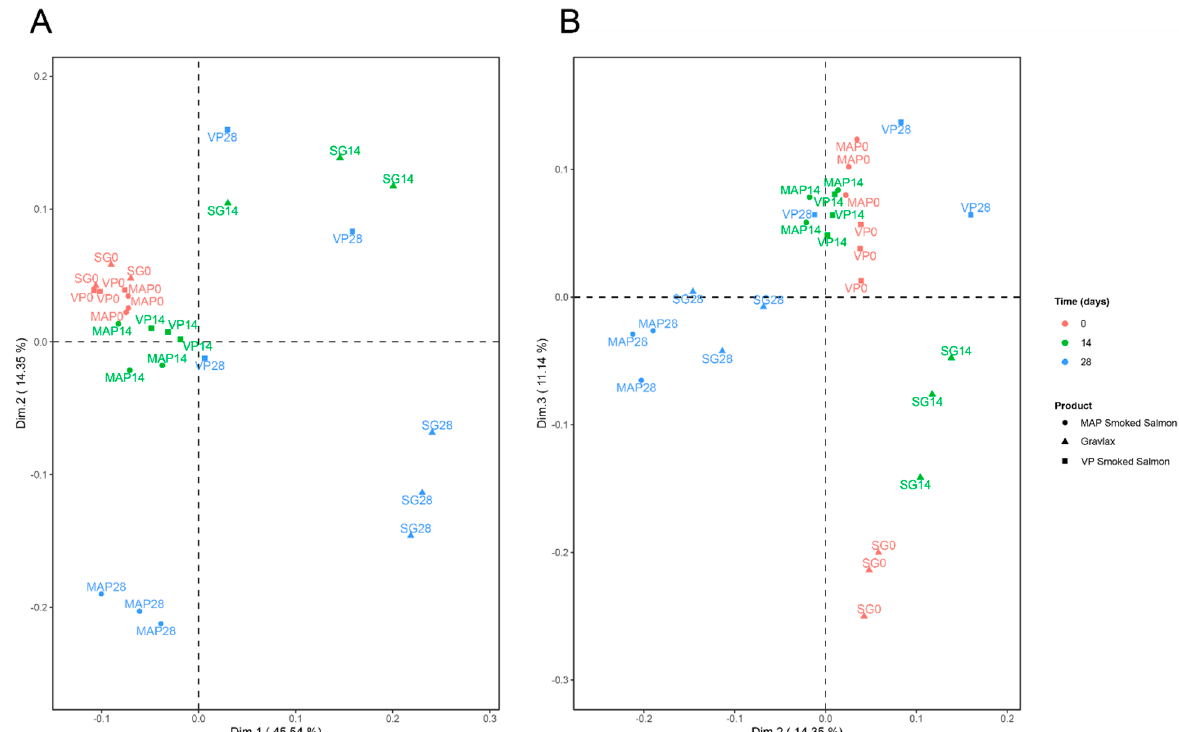
Figure 8. Multidimensional representation of the three products, namely, SG, MAP CSS and VP CSS, at three sampling time points using the various blocks of data collected by means of the ComDim method. ( A ) Projection of individuals in dimensions 1 and 2, ( B ) projection of individuals in dimensions 2 and 3. Numbers associated with the sample name correspond to the sampling date in days.